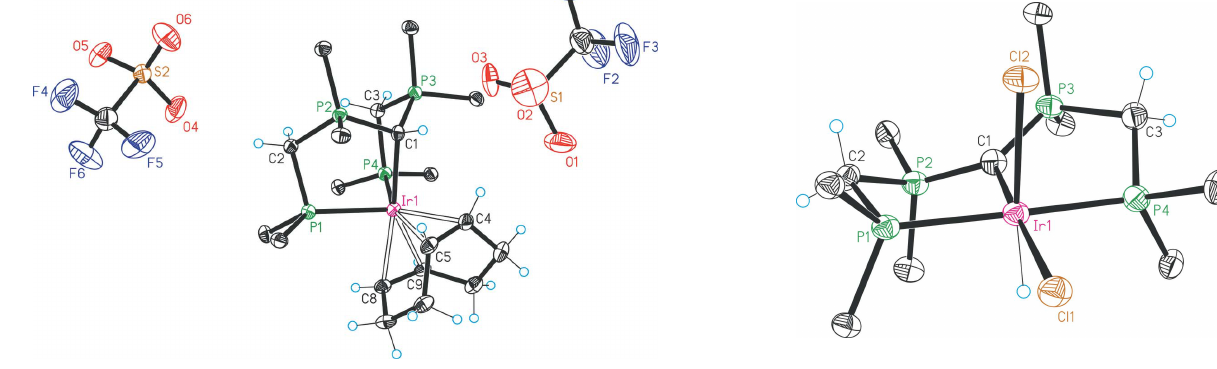
Figure 1 Structure of compound 1b , with atom labelling and 30% probability displacement ellipsoids. For clarity, only the ipso carbon atoms of the phenyl groups are shown, and the solvent molecules have been omitted.